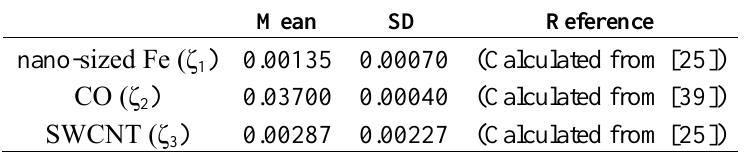
Table 3. Mean and standard deviations of the emission coefficients of nano-sized Fe, CO and SWCNT.